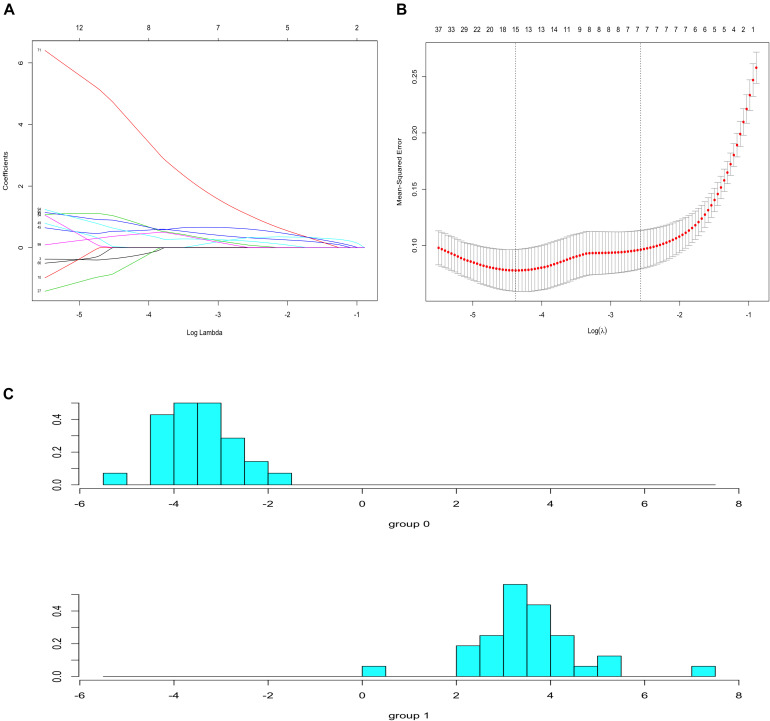
Lasso regression and LDA analysis. (A) Lasso coefficient profiles of 100 genes. (B) 10-fold cross-validation for selecting minimal λ based on 1-SE criteria for recurrence. A total of 15 genes were selected. (C) There was a clear shift in LDA function, with a left shift being observed for early plaques and a right shift for advanced plaques.